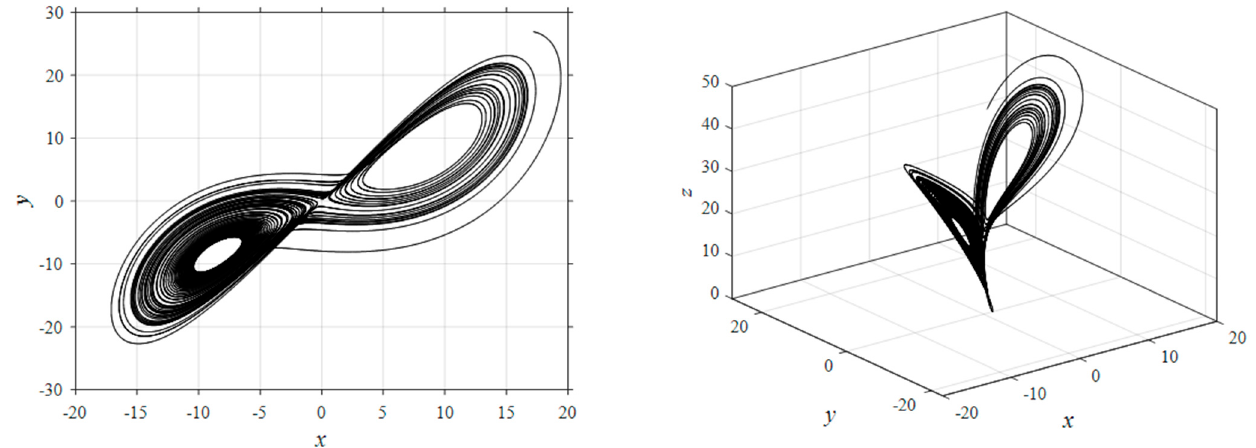
Figure 1. Fractional Lorenz system chaotic attractor using SINC-DQM with time ( T = 100 ) and fraction λ = 1, γ = 0.993, a 1 = 35, a 2 = 3, a 3 = 28, and x ( 0 ) = 1, y ( 0 ) = 1, z ( 0 ) = 1.